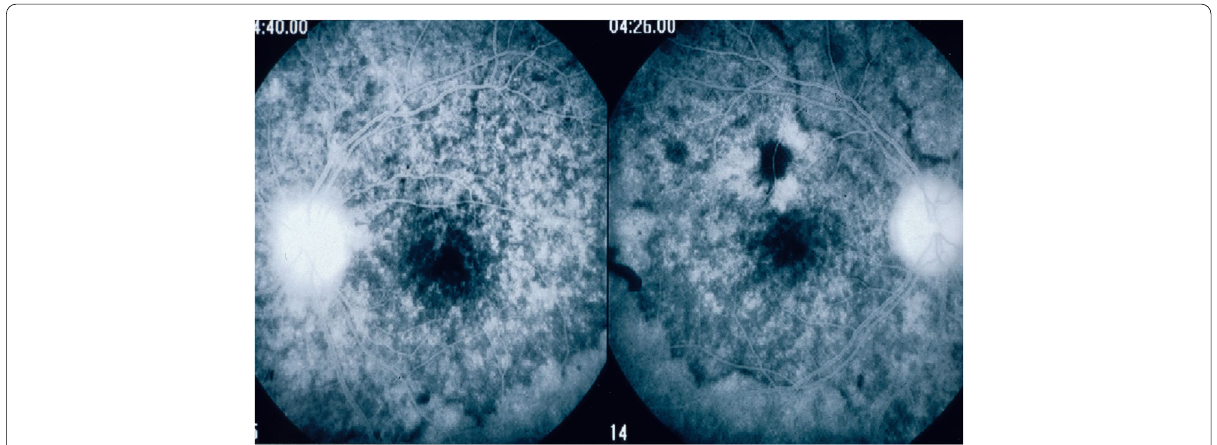
Fig. 5 Fluorescein angiogram findings in the chronic stage of VKH disease. Hyperfluorescent areas (window‑defect) and hypofluorescent areas (pigment clumps) are visible in the posterior pole. Note the high‑water marks, which indicate the extent of exudative retinal detachment. Note also the bright hyperfluorescence of both